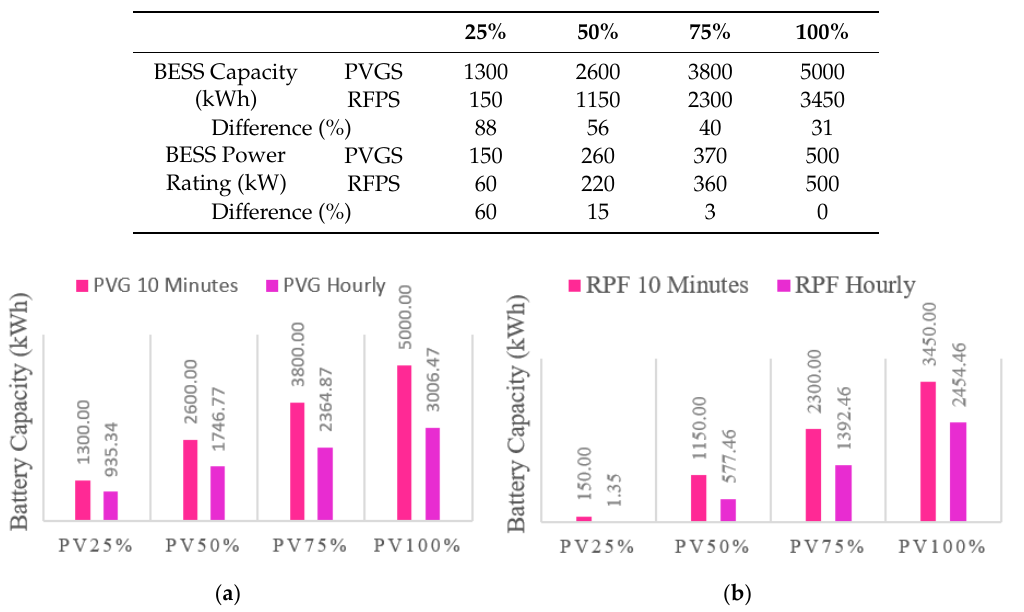
Figure 14. Comparison of BESS sizing for different time resolutions for strategies: ( a ) PVGS and ( b ) RFPS.